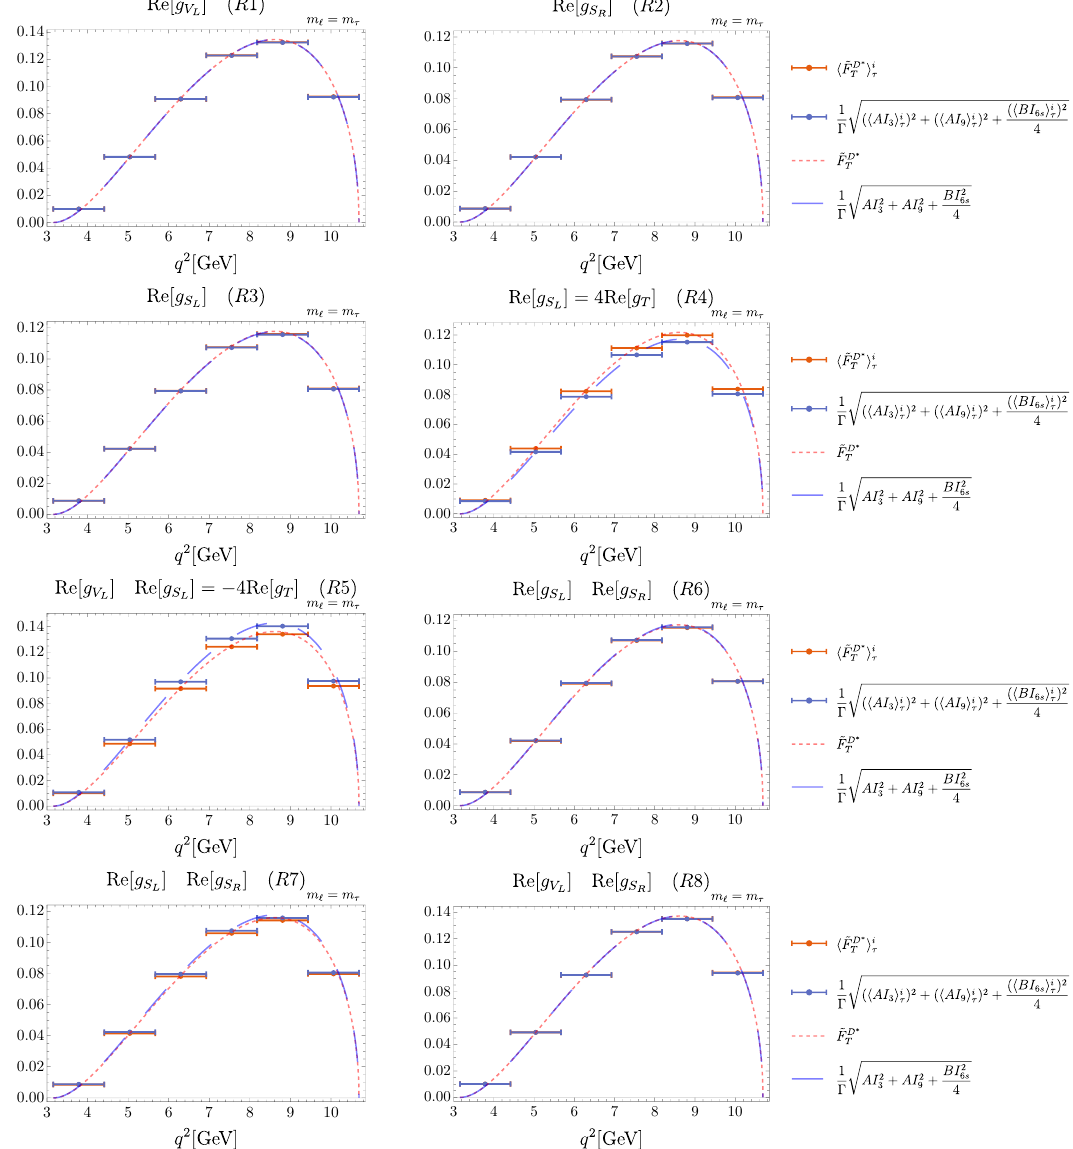
Figure 8. Study of binning e(cid:11)ects for eq. (4.17) for benchmark NP scenarios with real contribu- tions.